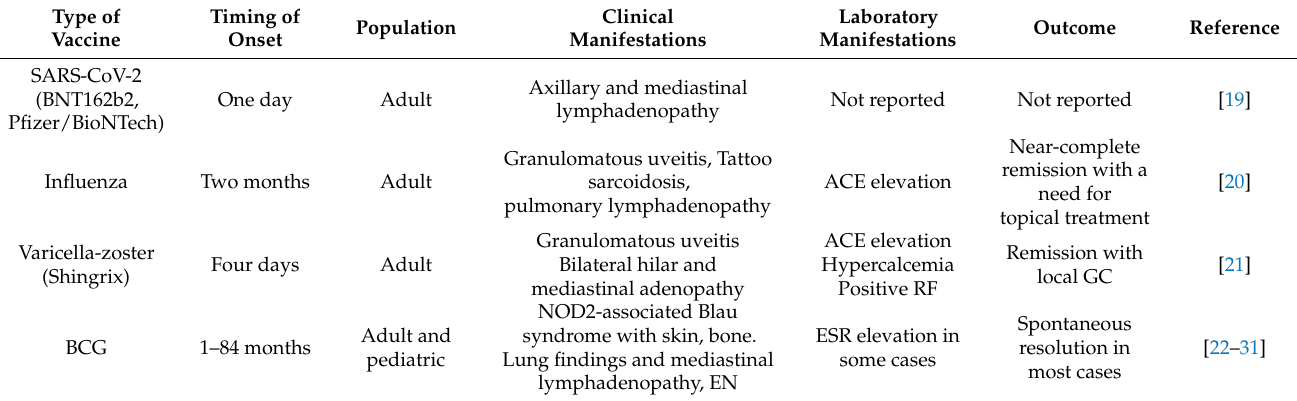
Table 1. Summary of findings of sarcoidosis cases after prophylactic